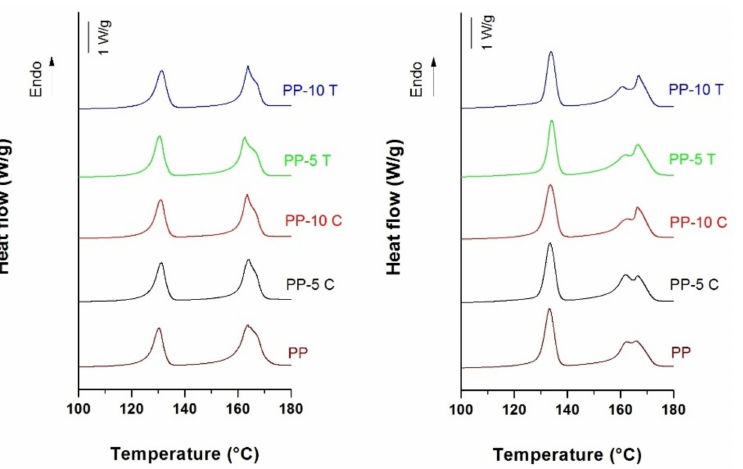
Figure 2. Heating thermograms of non-annealed precursor films ( left ) and membranes ( right ) with outer layers of neat polypropylene (PP), polypropylene filled with 5 wt% (PP-5C) and 10 wt% (PP-10C) CaCO 3 , polypropylene filled with 5 wt% (PP-5T) and 10 wt% (PP-10T)